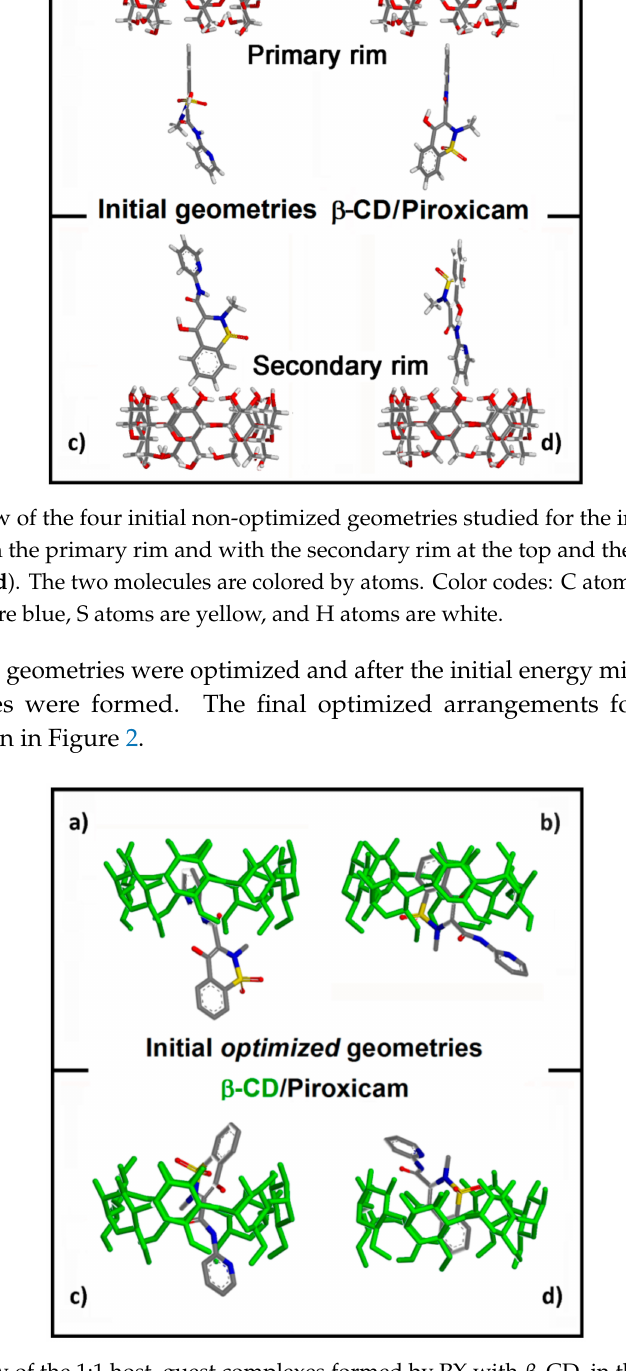
Figure 2. Side view of the 1:1 host–guest complexes formed by PX with β -CD, in the initial optimized geometries found after the MM calculations, starting from the four geometries reported in Figure 1 indicated respectively as ( a – d ). The β -CDs are green, the PX molecule is colored by atoms. Color codes: C atoms are grey, O atoms are red, N atoms are blue, S atoms are yellow, and H atoms are omitted for